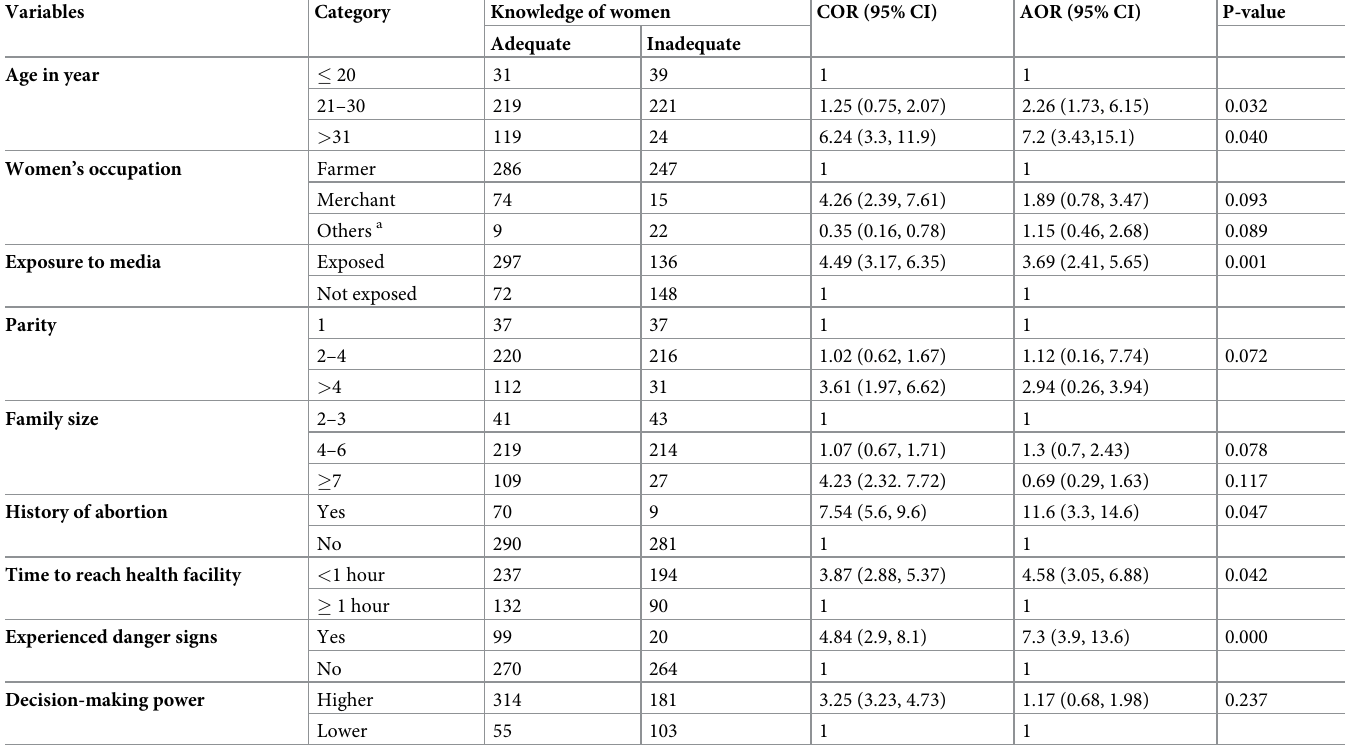
Table 5. Bi-variable and multivariable logistic regression analysis of factors associated with knowledge of antenatal care among women delivered at home in rural Sehala Seyemit district, northern Ethiopia, 2020 (n = 653).